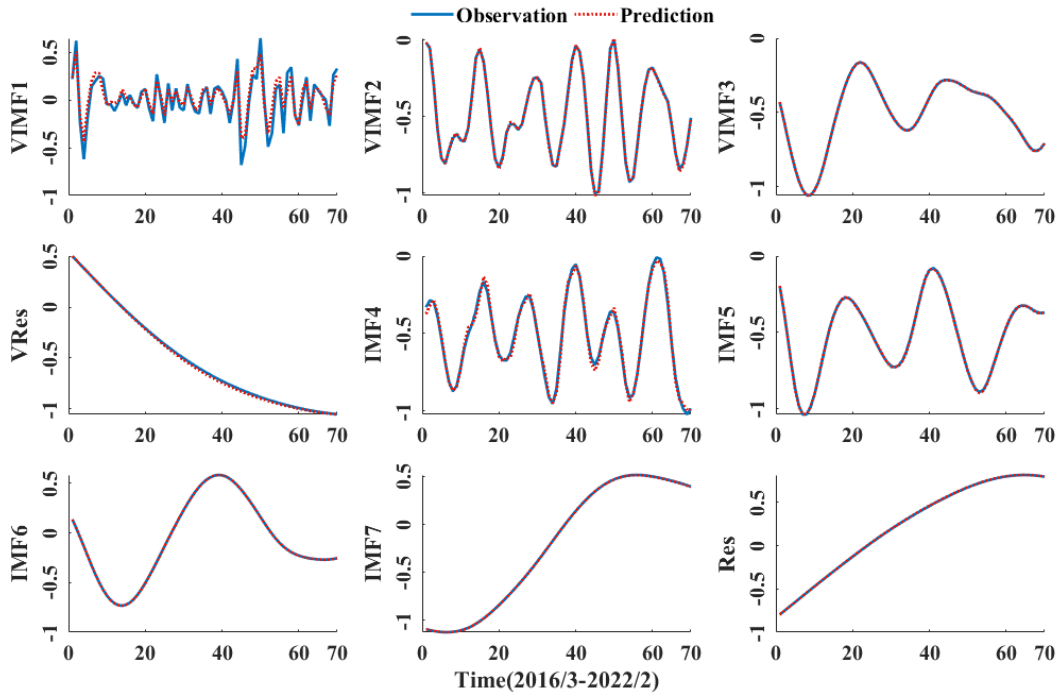
Figure 8. Predicted results for each component.